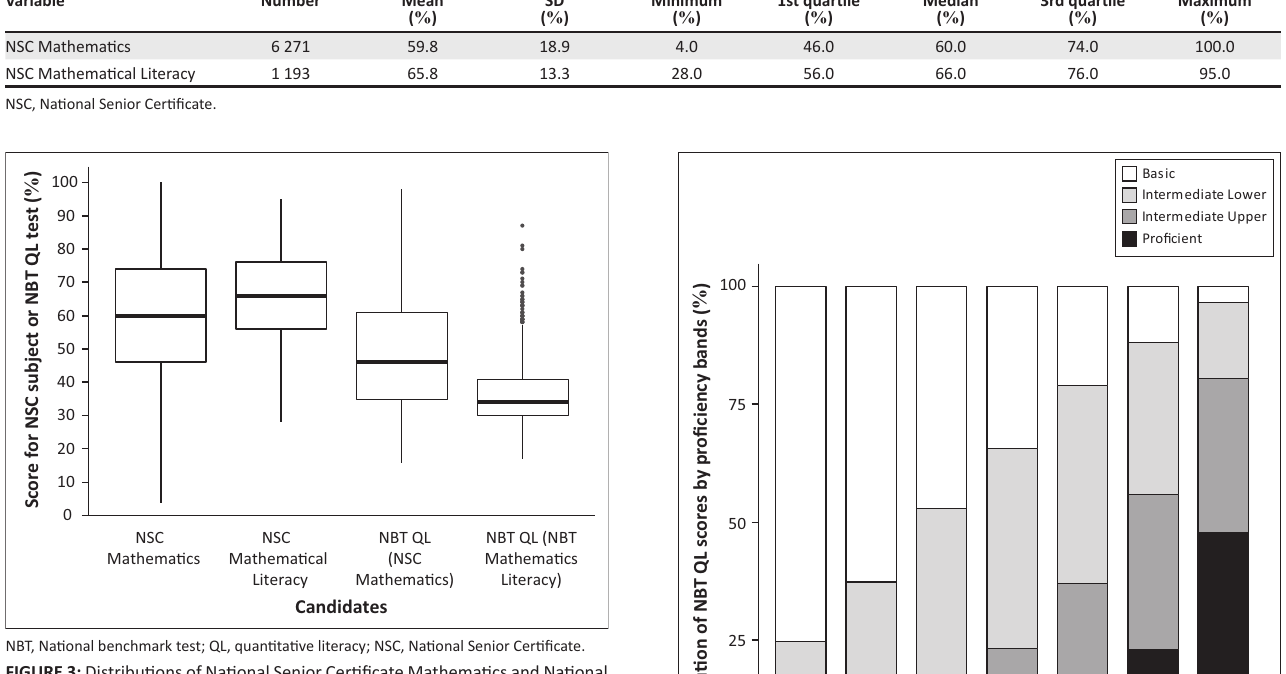
FIGURE 3: Distributions of National Senior Certificate Mathematics and National Senior Certificate Mathematical Literacy scores and of National Benchmark Test quantitative literacy scores for National Senior Certificate Mathematics candidates and National Senior Certificate Mathematical Literacy candidates.